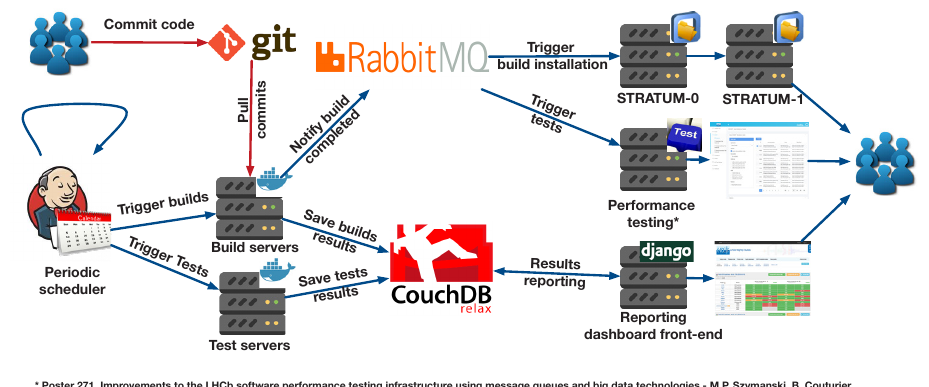
Figure 1. General architecture of LHCb continuous integration and deployment